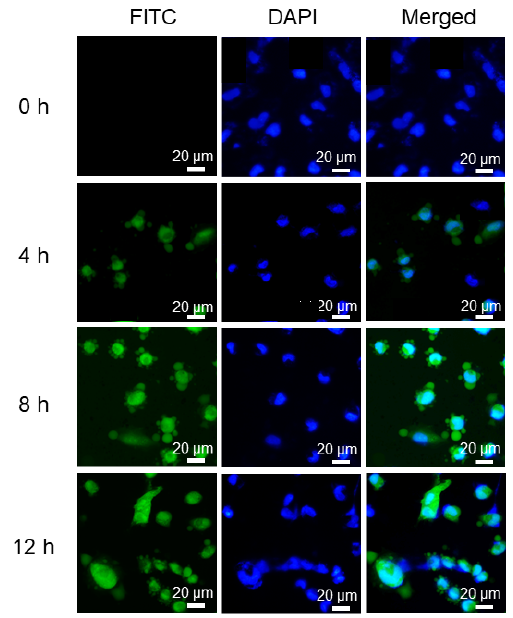
Figure 6. CLSM images of HeLa cells after being incubated with MQD@ZIF-8 for 0 h, 4 h, 8 h, and 12 h, respectively.